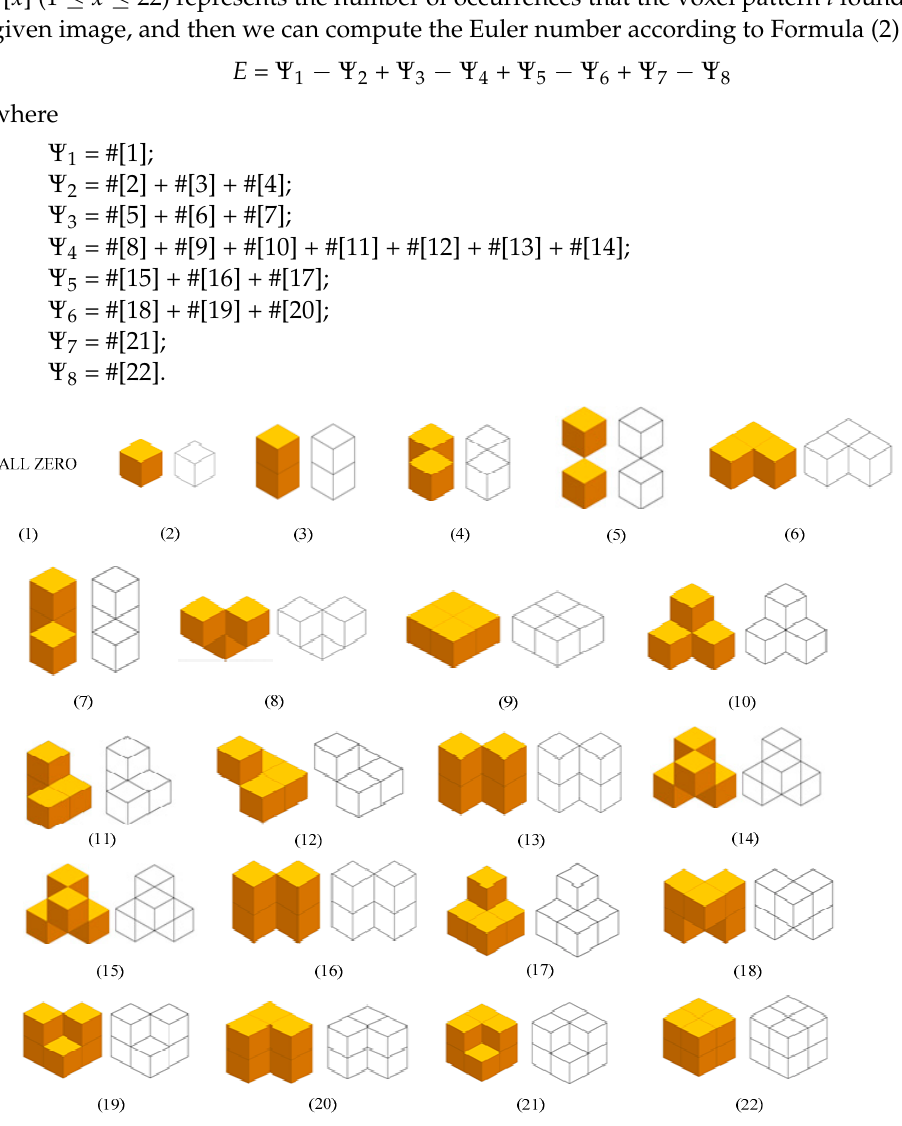
Figure 2. Di ff erent voxel pa tt erns found in the algorithm proposed in [30]. Figure 2. Different voxel patterns found in the algorithm proposed in